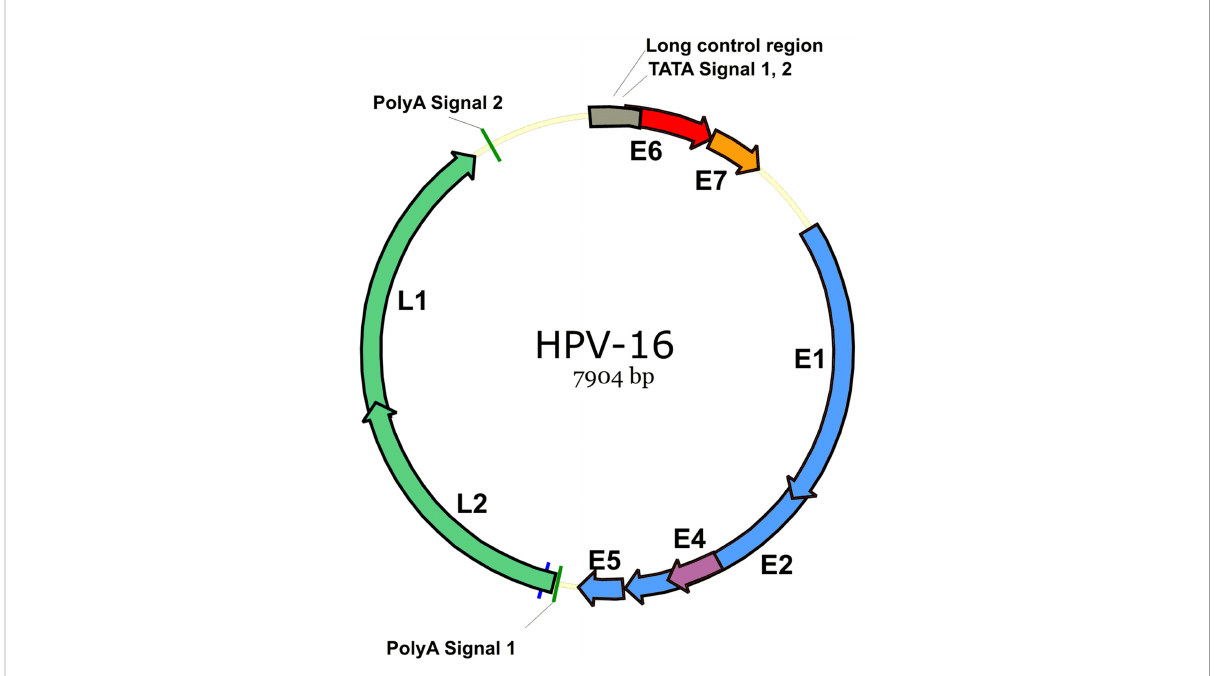
FIGURE 1 HPV-16 genome. HPV-16 is a relatively small, uncoated virus containing the L1 and L2 capsid proteins and the E proteins involved in proliferation and tumorigenesis (E1, E2, E4, E5, E6, E7), of which E6 and E7 are associated with tumorigenesis in cervical